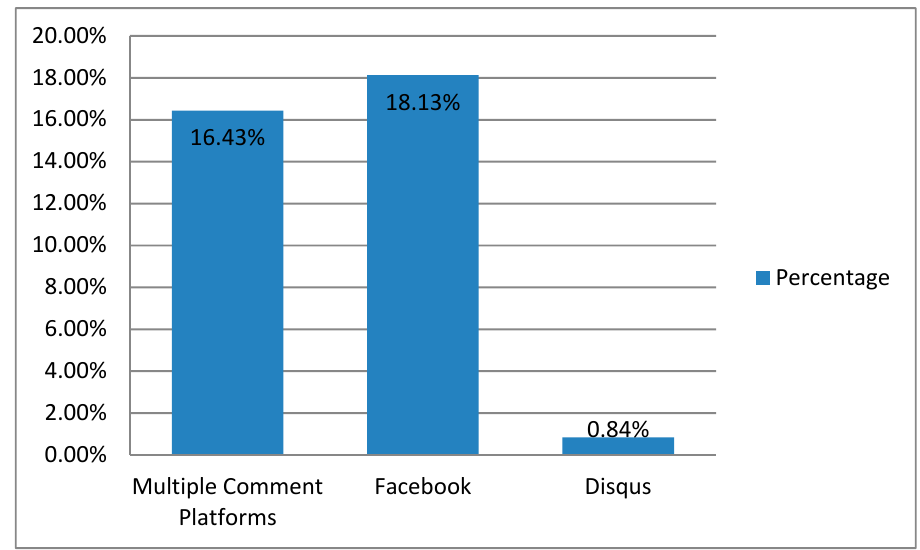
Figure 4. The Results of the Study for the International News Websites for the Commenting Platforms (n = 353).